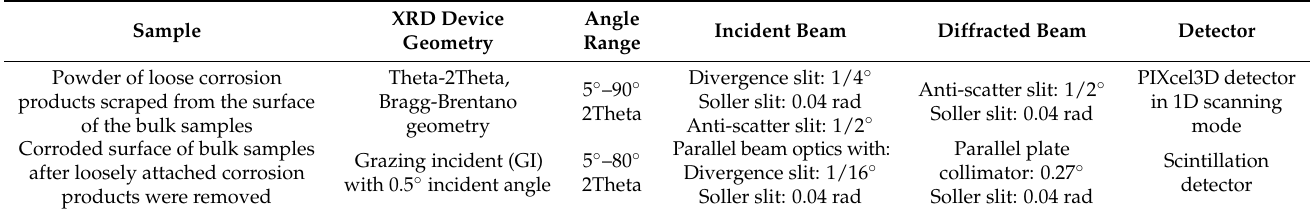
Table 2. List of XRD measurements